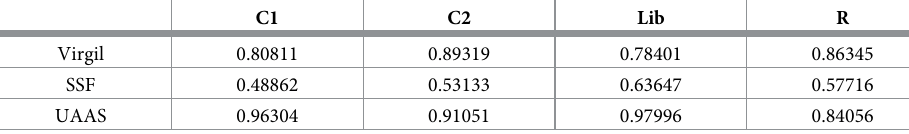
Table 5. Ranking accuracy values of Virgil, SSF, and UAAS.